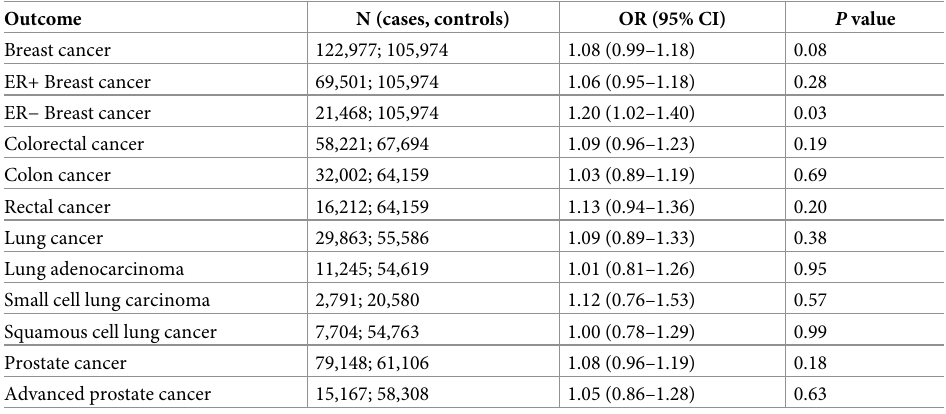
Table 4. Association between genetically proxied NCC inhibition and risk of overall and subtype-specific breast, colorectal, prostate, and lung cancer risk. Outcome N (cases, controls) OR (95% CI) P value Breast cancer 122,977;